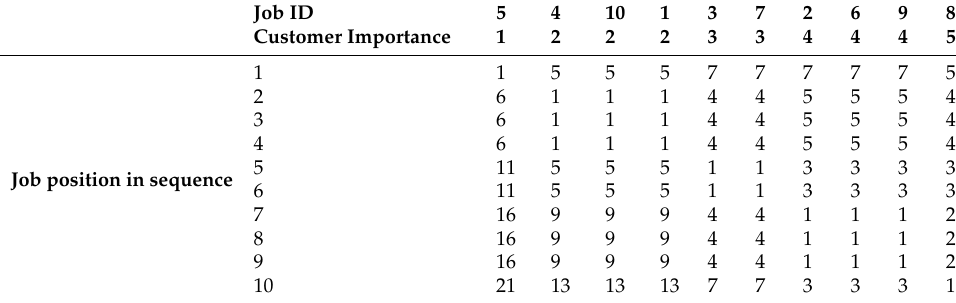
Table 3. Job sequence position penalization depending on customer importance.